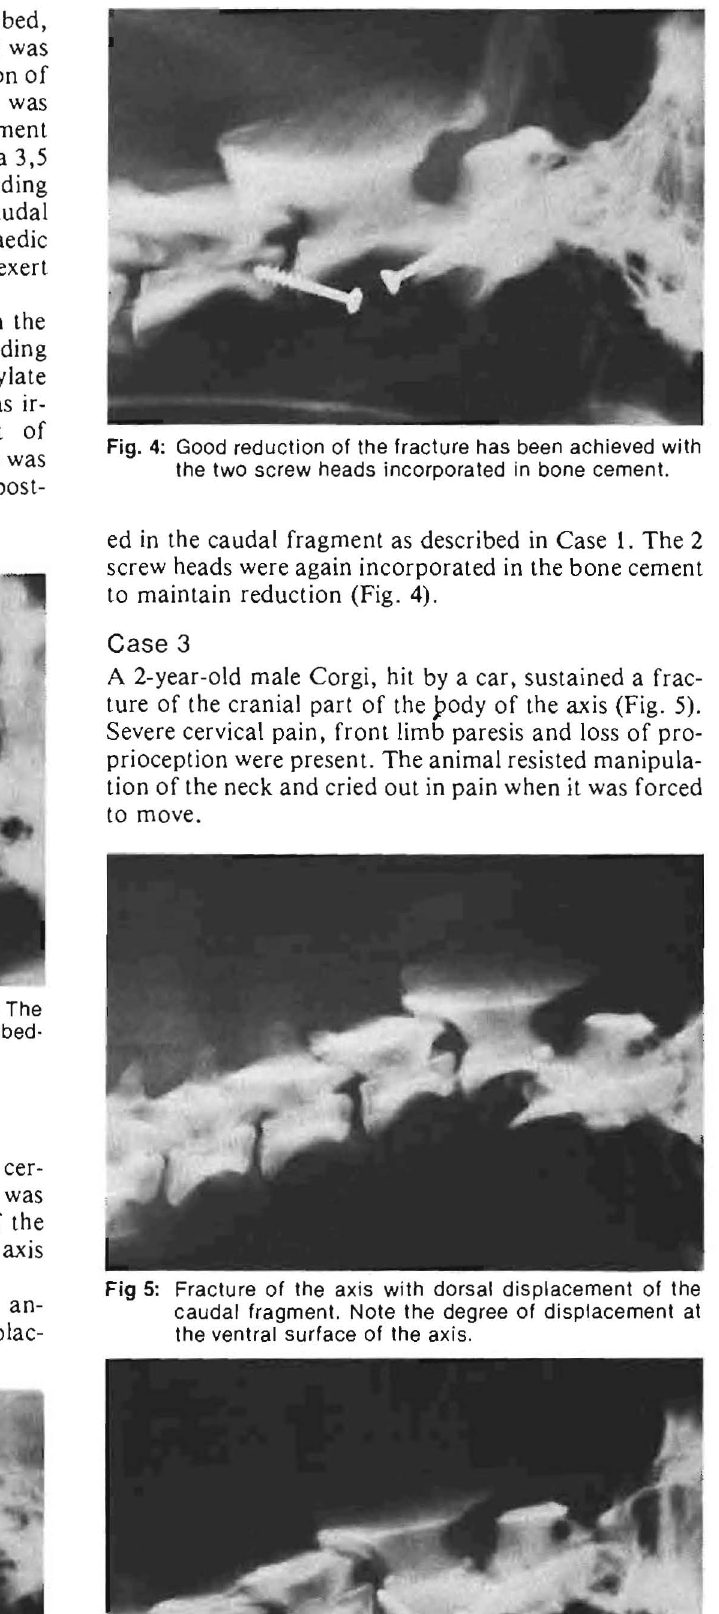
Fig 5: Fracture of the axis with dorsal displacement of the caudal fragment. Note the degree of displacement at the ventral surface of the axis.